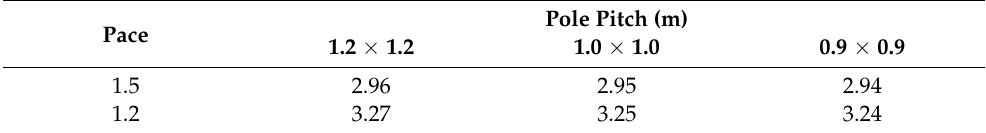
Table 5. Effective length coefficient µ of vertical bar based on theory of semirigid frame with lateral displacement.